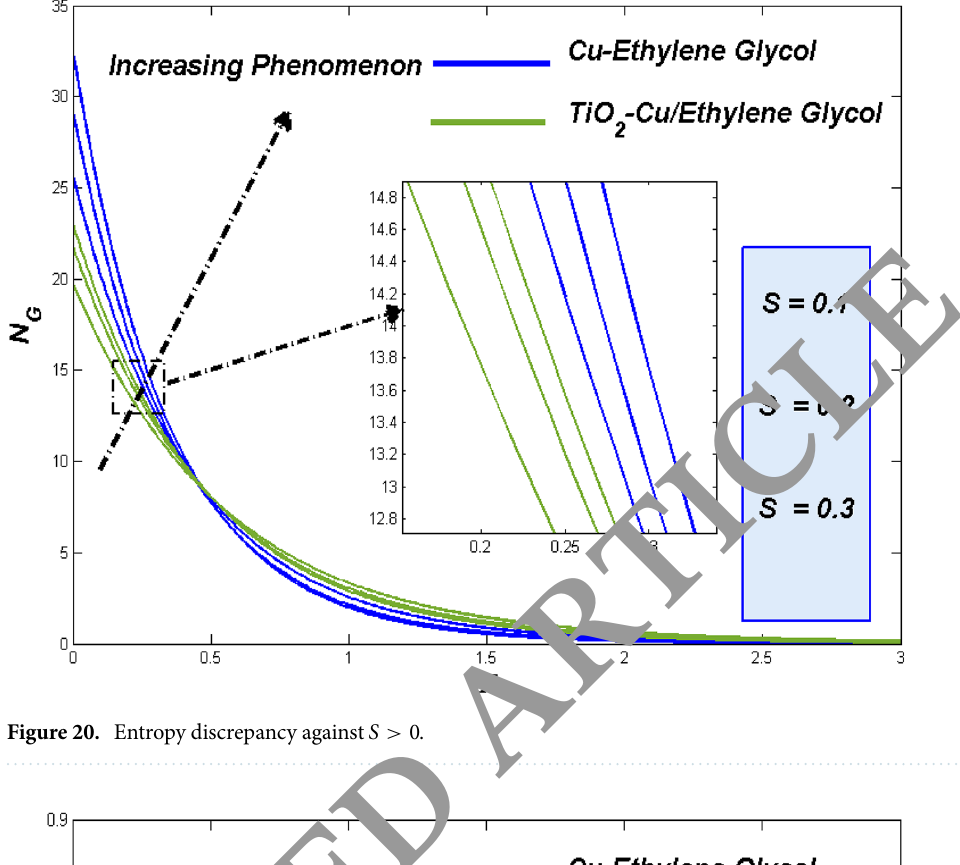
Figure 20. Entropy discrepancy against S > 0 .